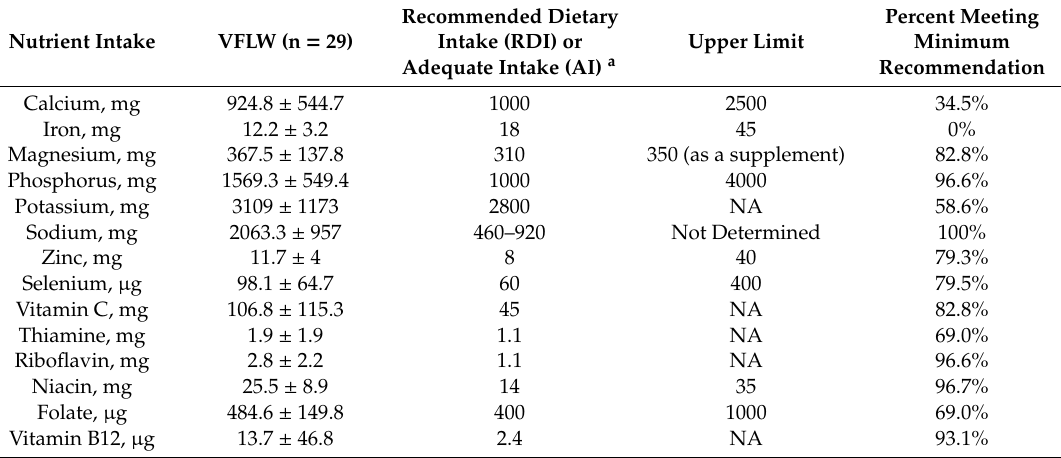
Table 3. Micronutrient intake of VFLW players (mean ± SD) and current recommendations.